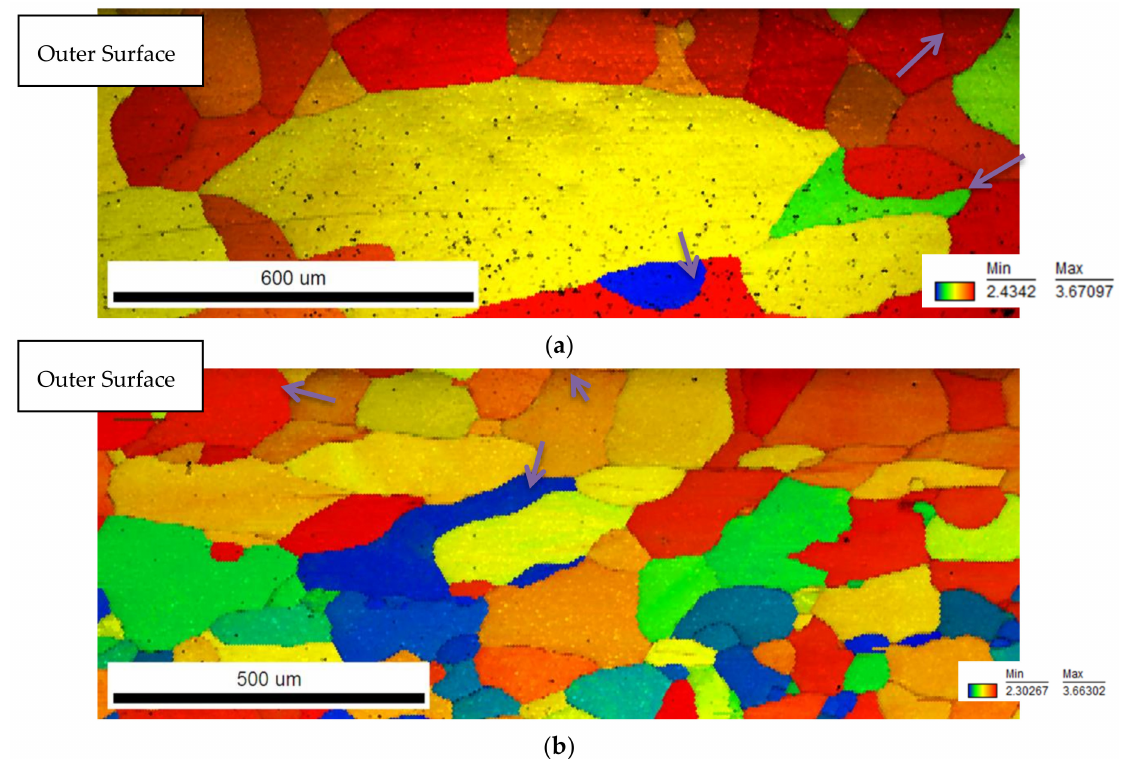
Figure 15. Taylor factor maps, secondary recrystallization was observed in 2.9 mm thick sample ( a ). Arrows indicate areas that exhibit anisotropic response to deformation and high stress concentration ( a ) sample with 2.9 mm thickness, ( b ) sample with 3.2 mm thickness. More prone to crack initiation are boundaries between blue and red colored